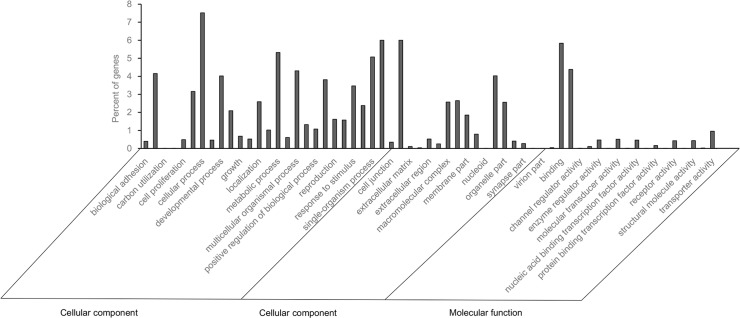
Distribution and comparison of male and female B. dorsalis unigenes annotated at GO level 2.The Y-axis shows the number of the sequence, the X-axis the areas of annotation and in each area, the sequences are further divided into subgroups at GO level 2.